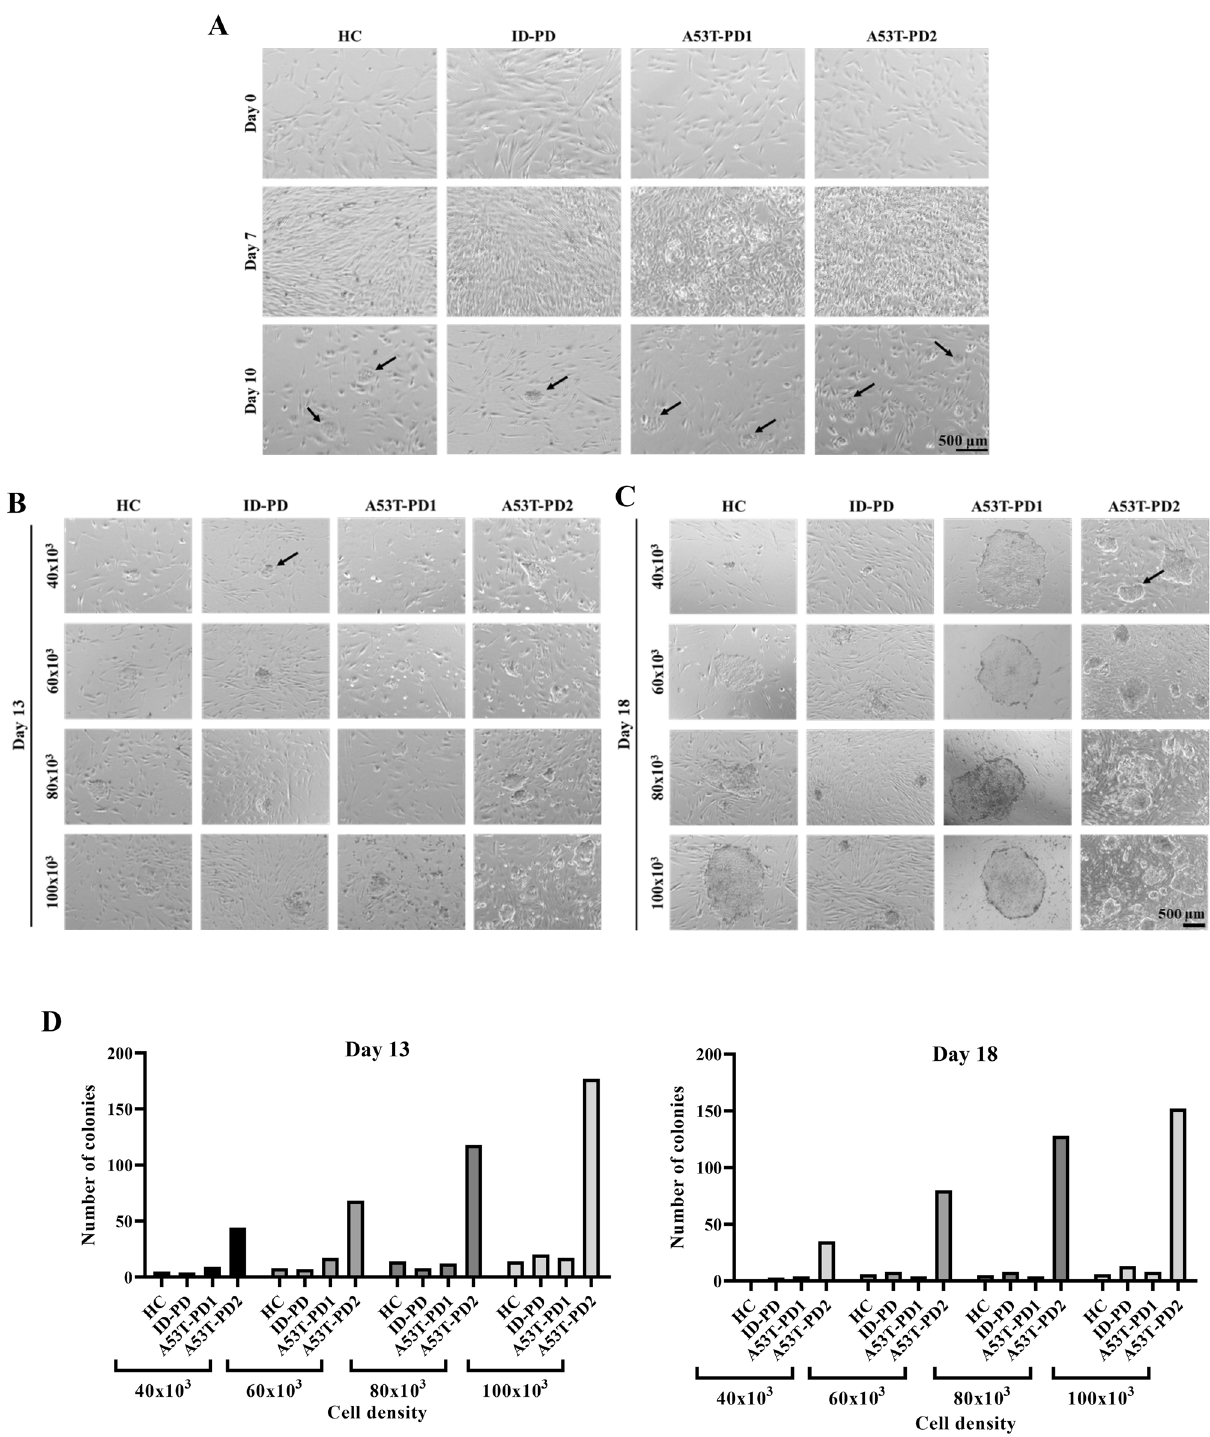
Figure 1. Fibroblasts from PD patients carrying the same mutation showed different iPSC reprogramming capacity. ( A ) Represents the early stages of control and PD fibroblast reprogramming. Fibroblast morphology was observed on day 0 and day 7 post transduction. After transferring the cells onto Matrigel coated plates, observable cell clumps have appeared on day 10 post transduction and are indicated by the black arrows. ( B , C ) Represents the reprogramming efficiency of the four reprogrammed samples. The shape and size of the emerged iPSC colonies in different cell densities were observed on day 13 ( B ) and day 18 ( C ) post transduction and the arrow in each figure indicates the minimum size of the counted colonies in each day. ( D ) Represents the number of emerged iPSC colonies plotted against the different cell densities for each reprogrammed sample on day 13 and 18;